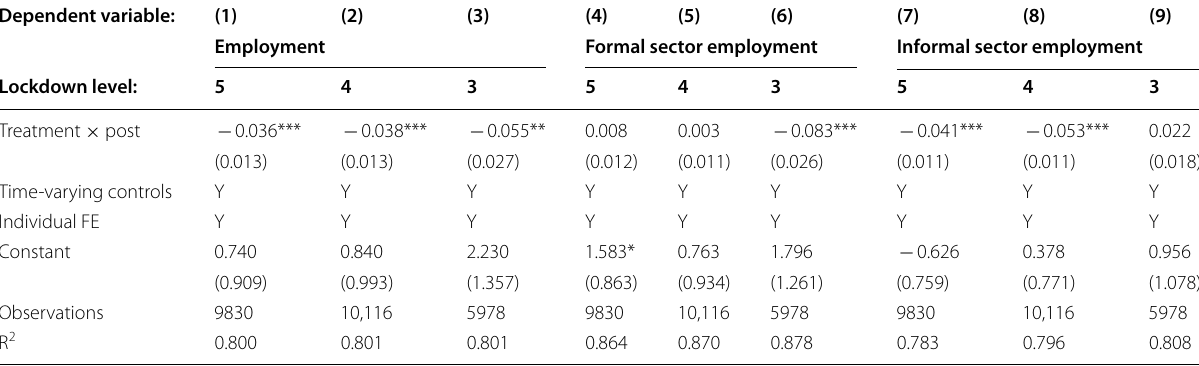
Table 6 Model estimates of heterogenous lockdown effects on employment probabilities, by formality and lockdown